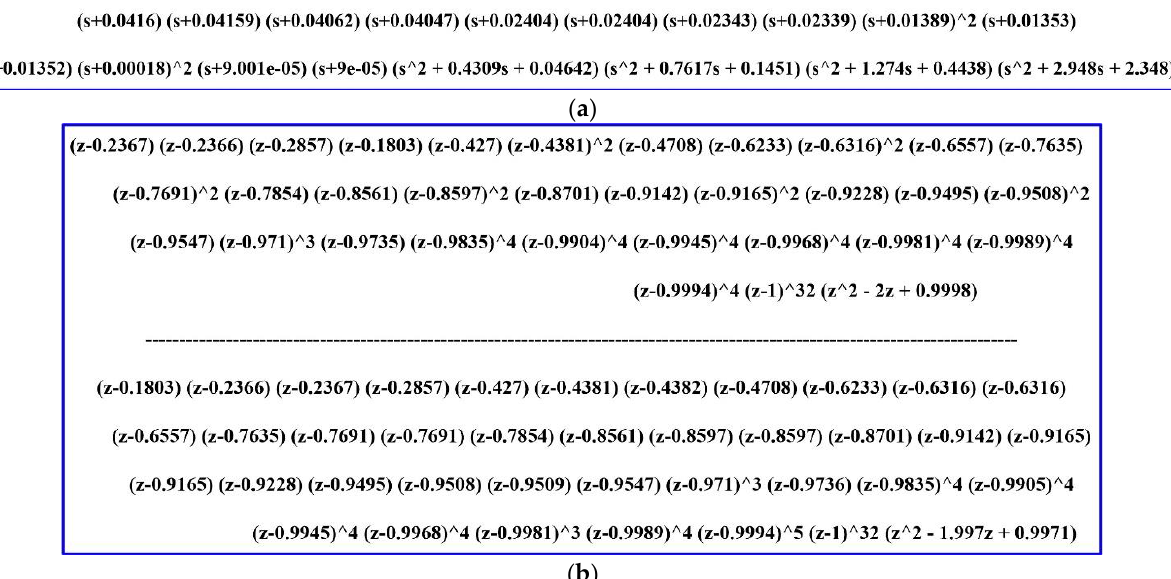
Figure A3. Transfer functions for the FO lead-lag controller: ( a ) continuous form; ( b ) discrete form.